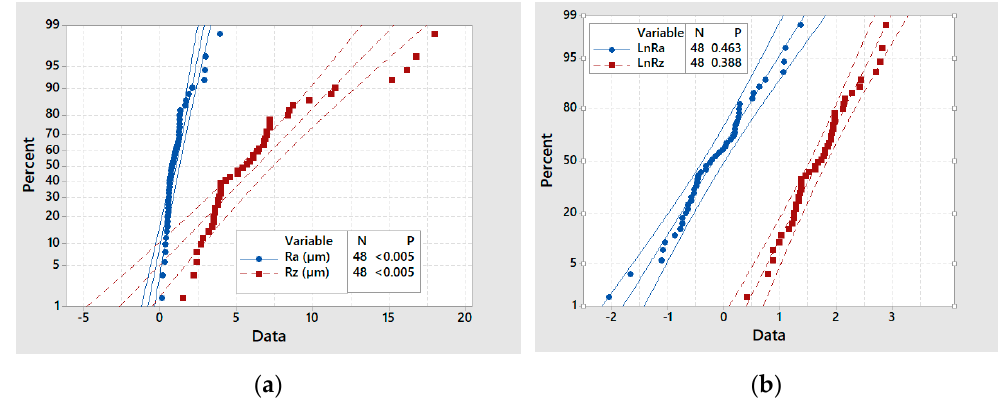
Figure 9. Probability plots: ( a ) Ra and Rz; ( b ) Ln Ra and Ln Rz . Table 8. Homogeneity test of variances for factors f and N and response variables LnRa and LnRz .